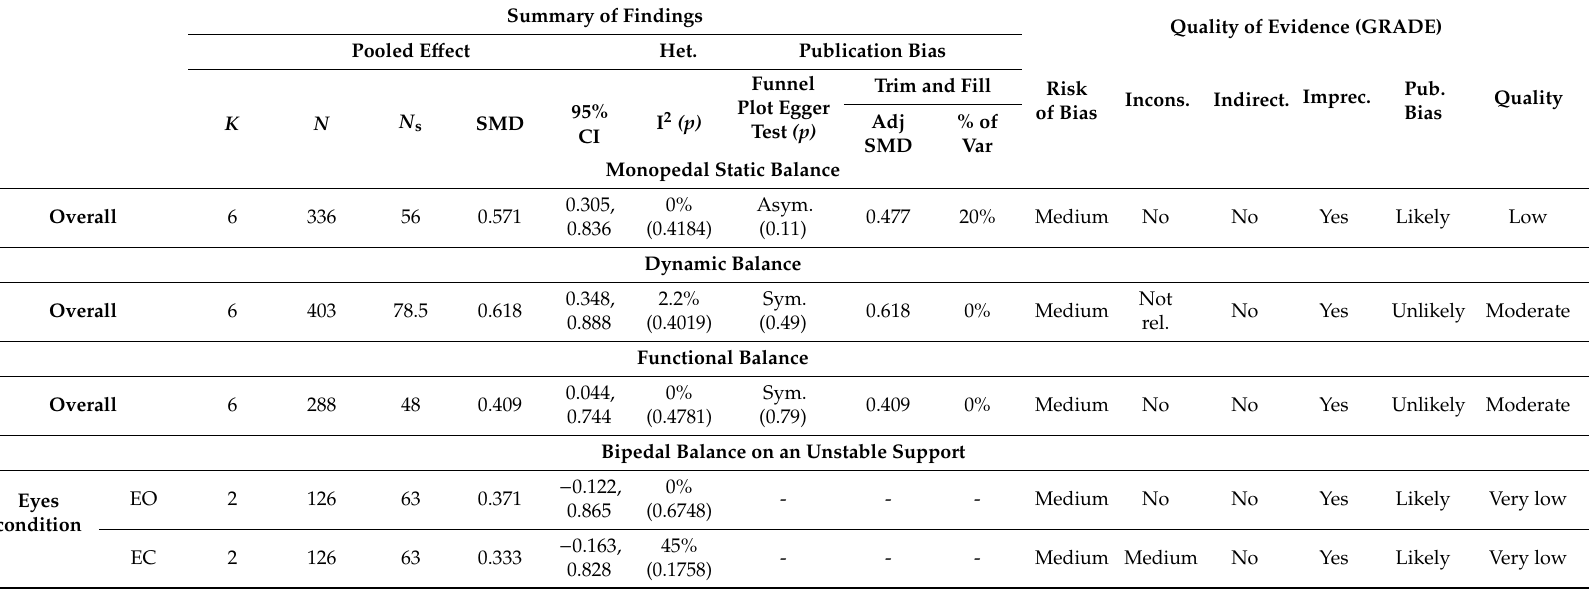
Table 4. Main findings in